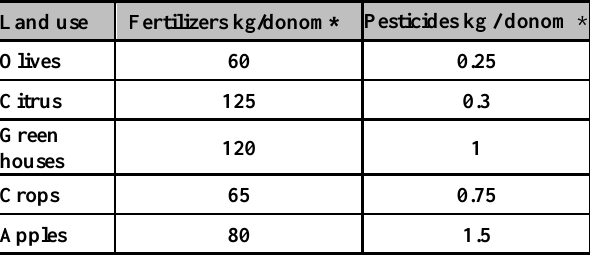
Table (1): Average Fertilizes (Phosphorous, Nitrogen and Potassium) and Pesticides Loads by Land Use in Al – Abrash River Basin